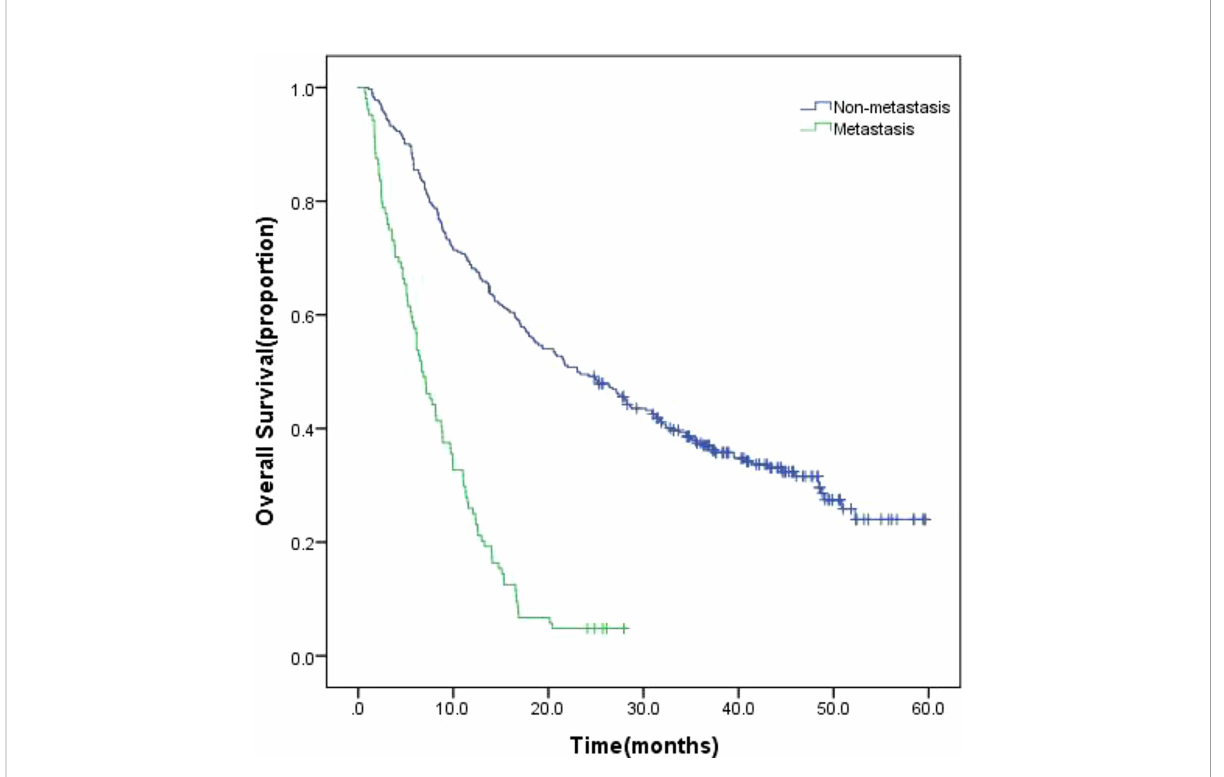
FIGURE 6 Kaplan-Meier survival curves of all enrolled